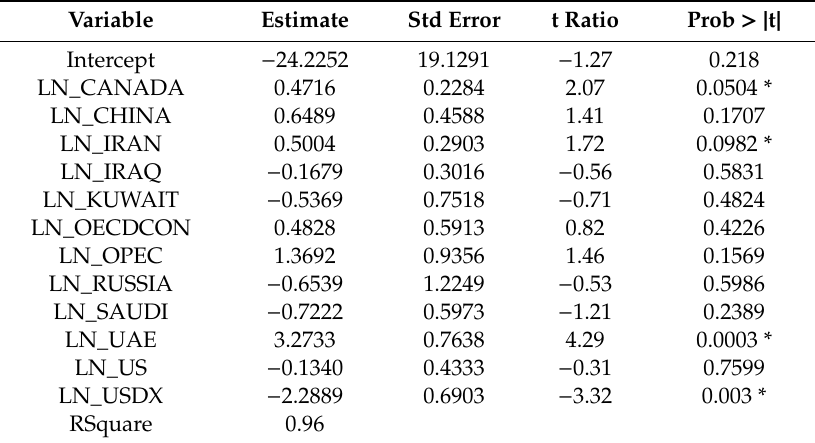
Table 14. Panel 5 period (2010–2012): LN_BRENT prediction-parameter estimation. Variable Estimate Std Error t